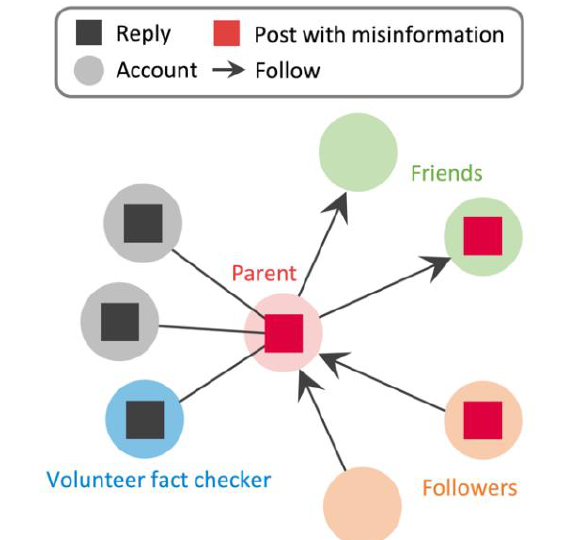
Figure 1. Schematic of our strategy that identifies misinformation online by tracking footprints of volunteer fact checkers. Starting from the volunteer fact checker (blue node) who provides accurate information, we can first identify misinformation in the parent post (red node) and then further detect misinformation in the upstream (friends; green nodes) and downstream (followers; orange nodes) peers of the